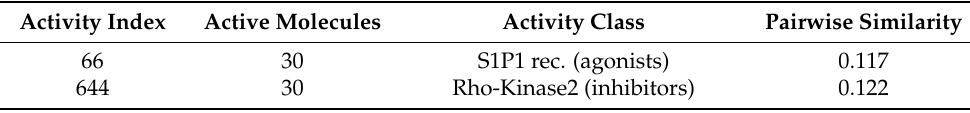
Table 4. MUV structure activity